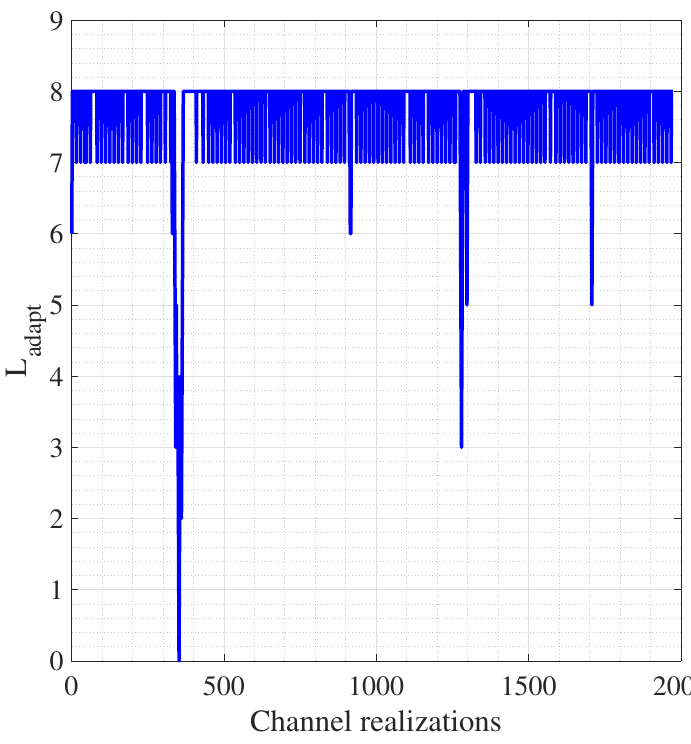
Figure 4. Values of L adapt in Equation (18) when different channel realizations are